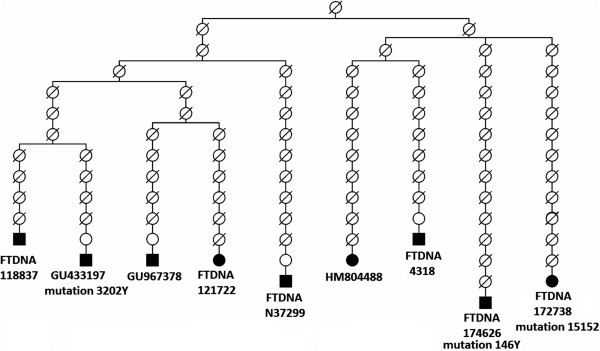
Acadian pedigree.